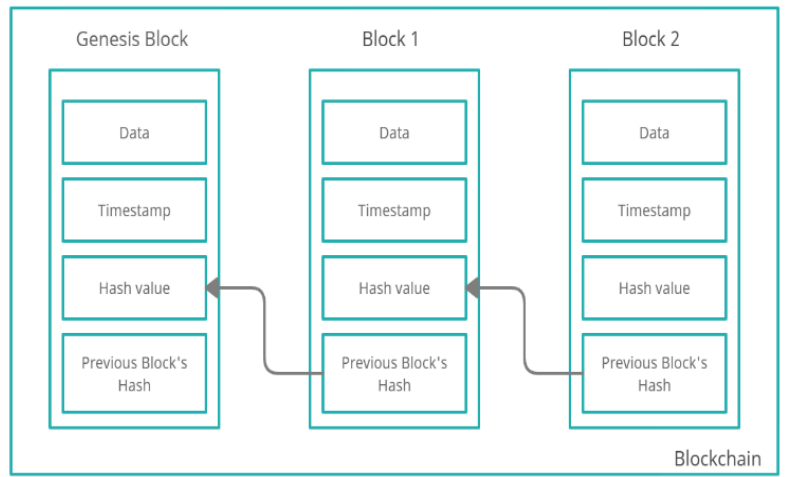
Figure 1. The structure of a Blockchain system.